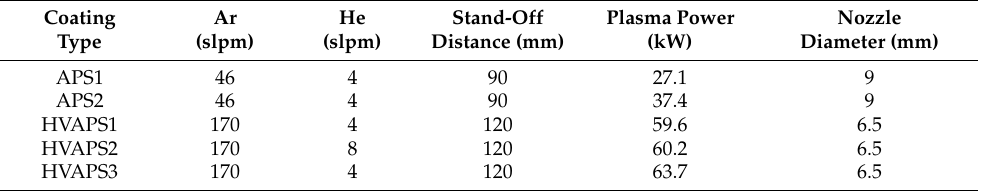
Table 1. Mean APS process parameters for the deposition of the